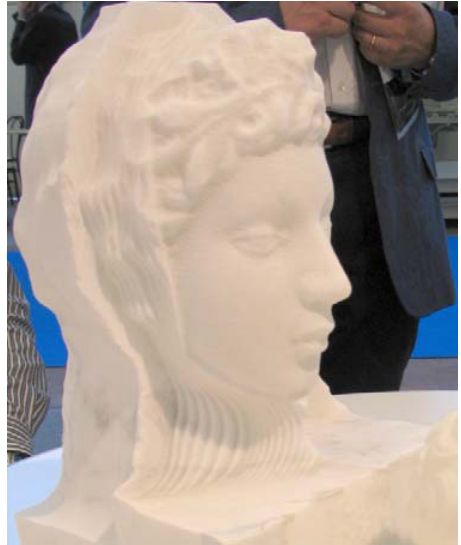
Figure 12: The marble replica of a statue’s head at an intermediate working phase: subsequent step of machining are visible; the level of detail showed on the face is the